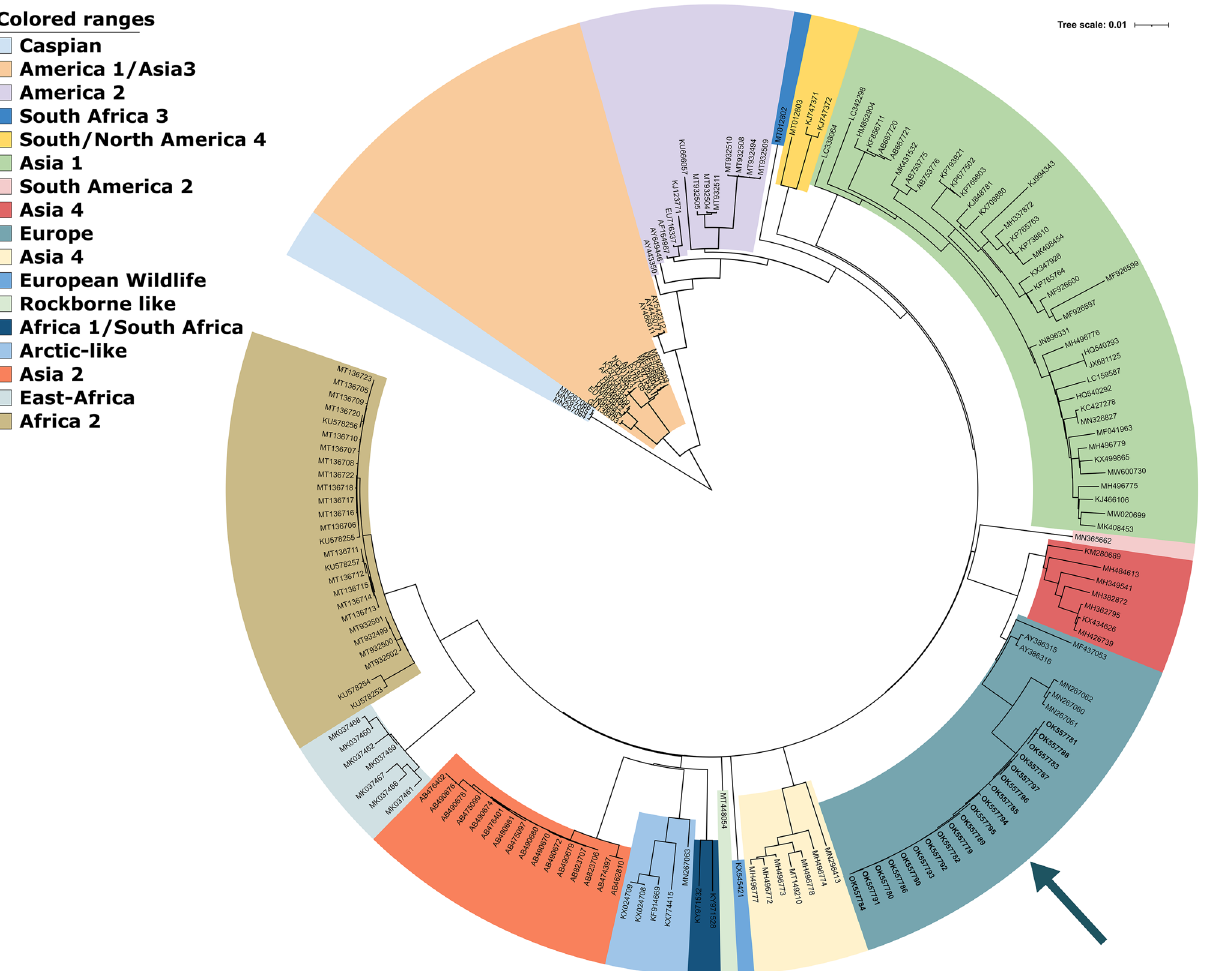
Figure 1. Maximum Likelihood phylogenetic tree based on 179 CDV complete genomes nucleotide sequences. Phocine distemper virus (PDV) (GenBank accession number: KY629928) was used as an outgroup to root the phylogenetic tree. The Europe lineage of interest is highlighted in light